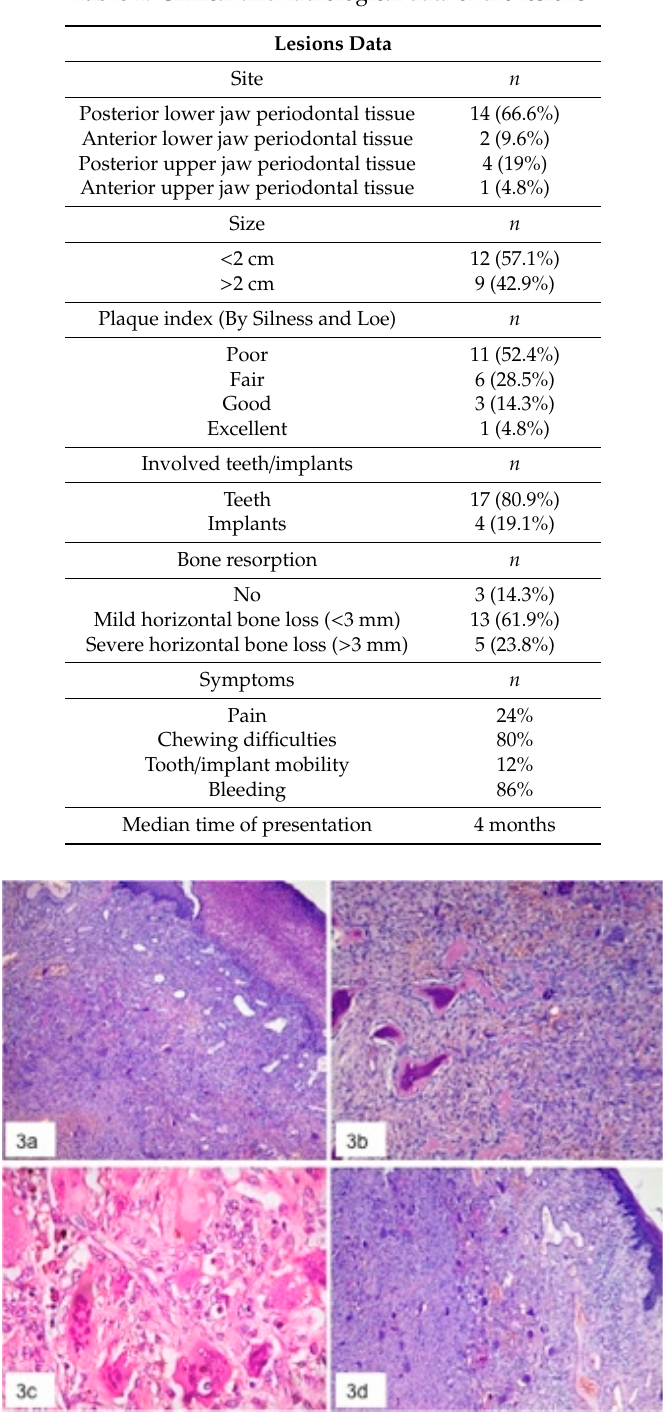
Table 1. Clinical and radiological data of the lesions.